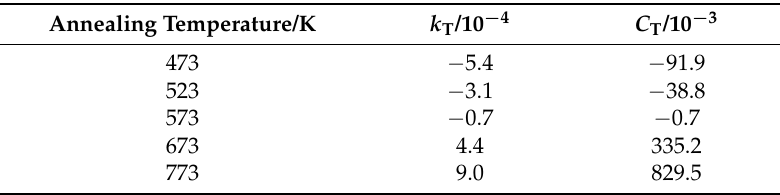
Table 2. The linear regression fitting results for each of the annealing